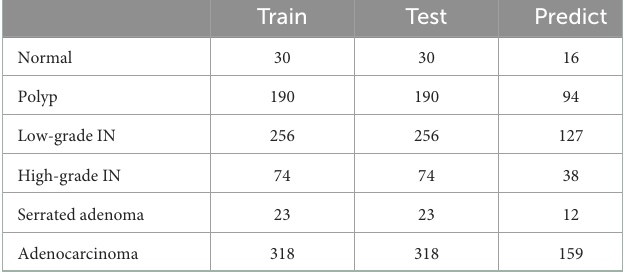
TABLE 4 Deep learning of the number of different types of training images. Train Test Predict